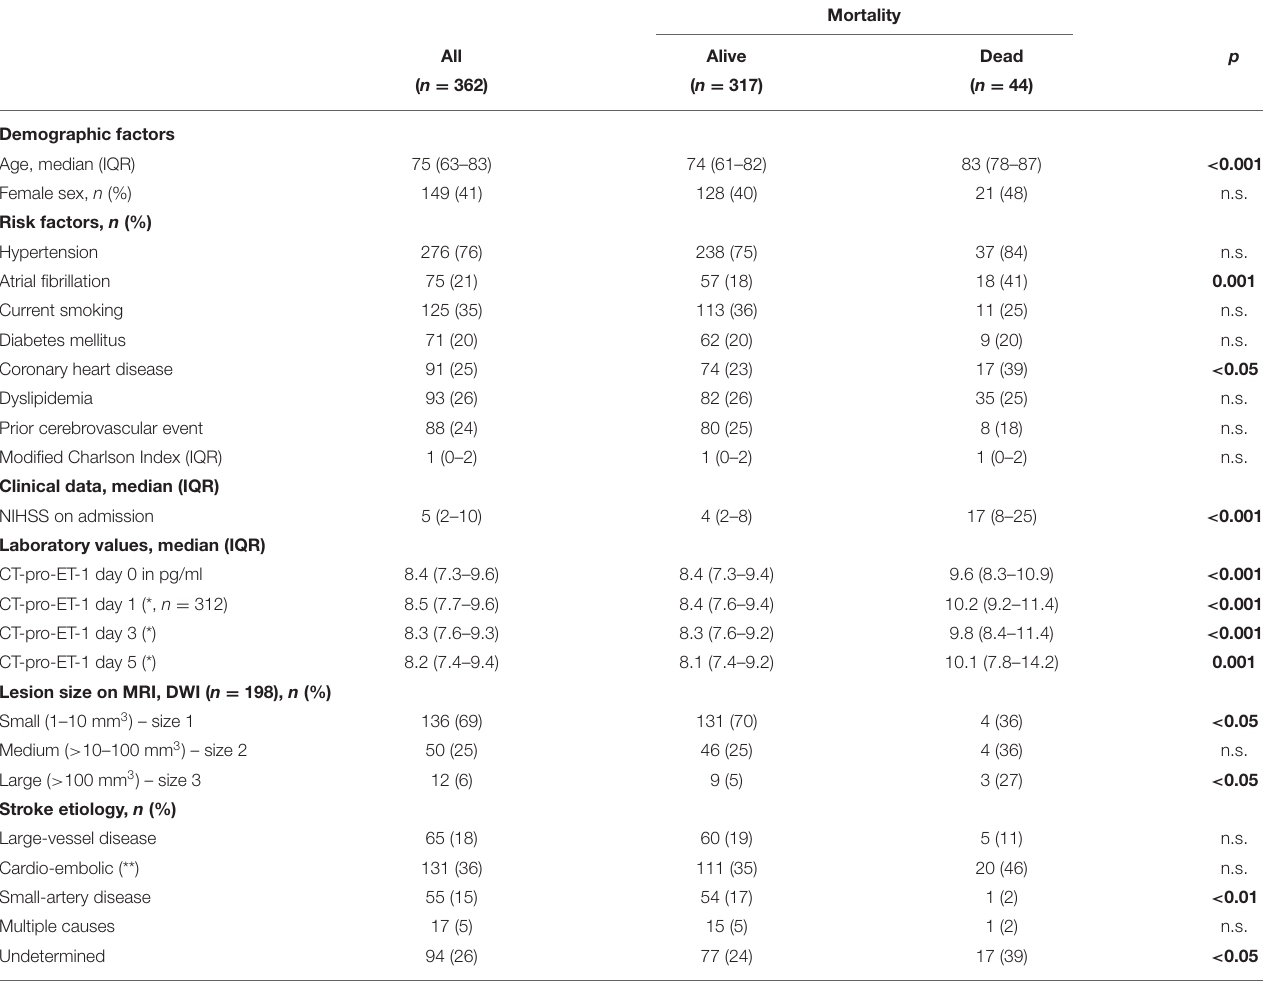
TABLE 1 | Baseline characteristics of stroke patients, stratified by mortality after 90 days.